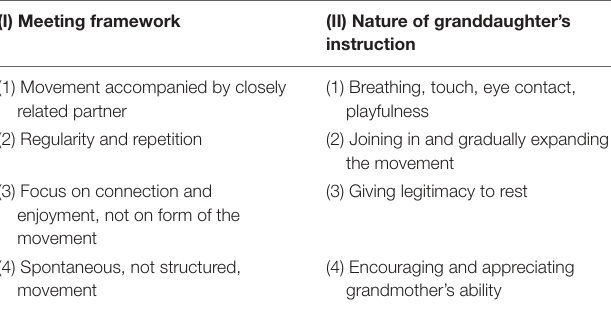
TABLE 3 | Unique components for a successful